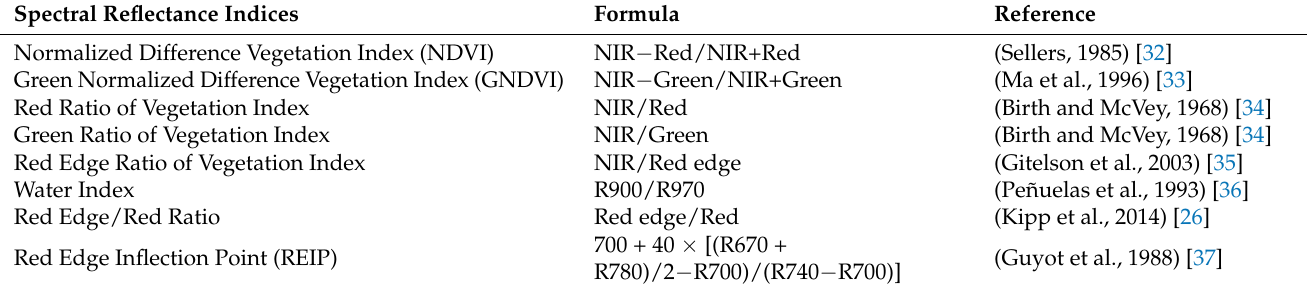
Table 3. Vegetation indices and their formulas calculated in the present work.